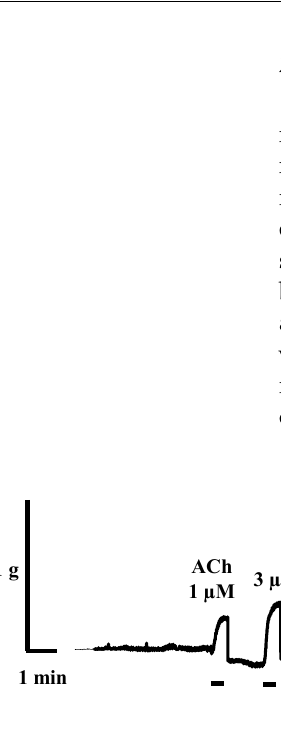
Figure 2. Effect of carvacrol on contractions of Parascaris sp. muscle strips produced by acetylcholine. Isometric contractions of Parascaris sp. muscle flap produced by increasing concentrations of acetylcholine (ACh) from 1 to 100 µM (left panel, short bars) and inhibition of contractions mediated by 300 µM carvacrol (middle panel, full line). Absence of ACh-induced response recovery after washing the preparation (right panel).